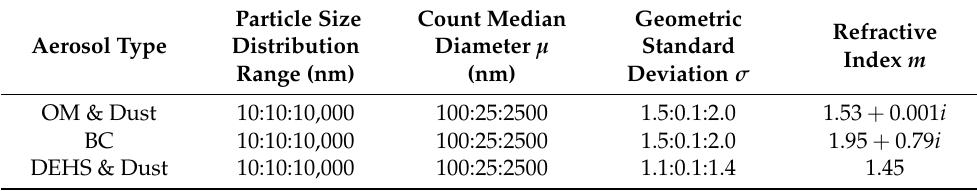
Table 2. The PM and DEHS parameters in human main activity areas.